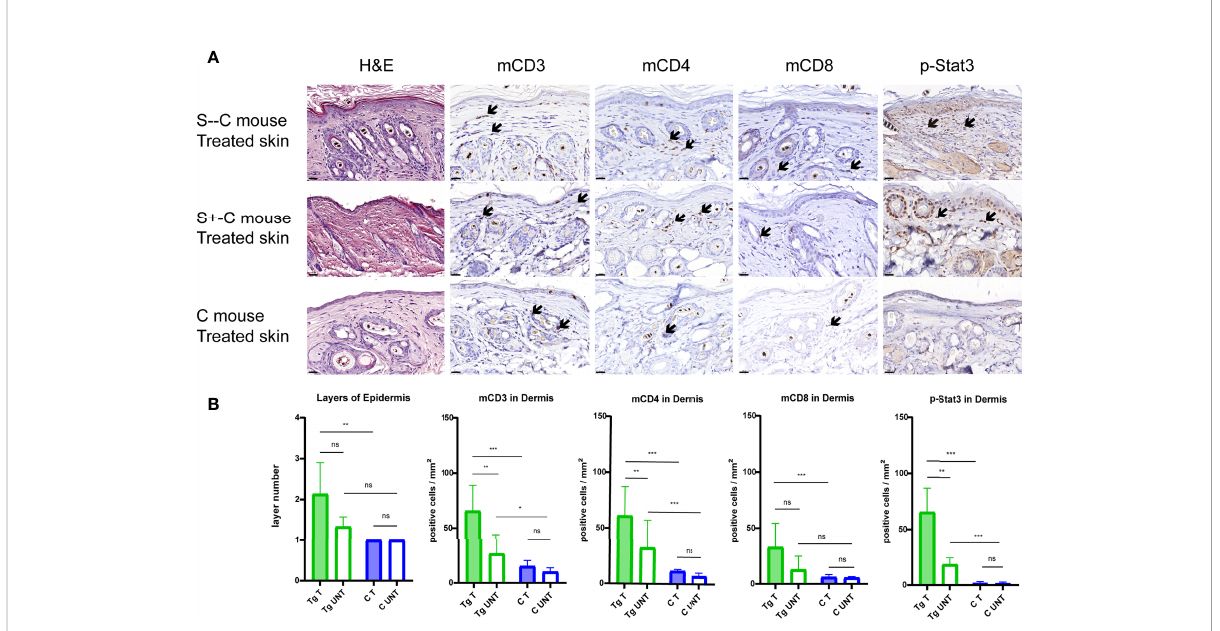
FIGURE 5 Detailed histological analyses using H&E and immunohistochemical staining of murine skin sections. (A) . Representative photomicrographs of treated skin from S – C mice, S+-C mice and C mice respectively. Black arrows: D hCD4 positive cells. Scale bar: 50 m m. S – C is Socs1 -/- Cd4Cre +/-; S+-C is Socs1-/wt Cd4Cre+/-; C is control group. (B) . Quanti fi cation of the layers of epidermis, in fl ammatory cells and pStat3 positive cells in the dermis from transgenic group (S – C mice, S+-C mice) and C mice. Data are presented as mean ± SD. (N=5 and 3 in each group).